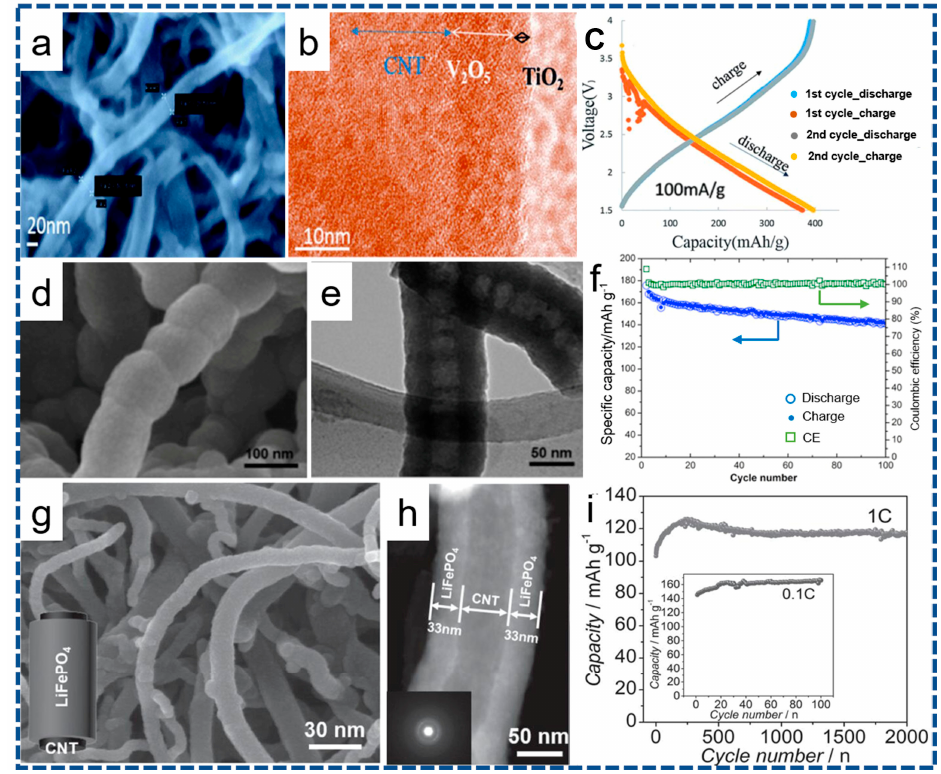
Figure 4. ( a , b ) SEM and TEM images of the TiO 2 /V 2 O 5 /CNTs paper electrode. ( c ) Voltage profile of the TiO 2 /V 2 O 5 /CNTs paper electrode for lithium ions storage. ( d ) SEM and ( e ) TEM image of the FePO 4 /NCNTs. ( f ) Cycling stability of the FePO 4 /NCNTs at a current density of 178 mA·g − 1 . ( g ) SEM and ( h ) TEM images of the LiFePO 4 @CNTs. ( i ) Cycling performance of the LiFePO 4 @CNTs cathode.